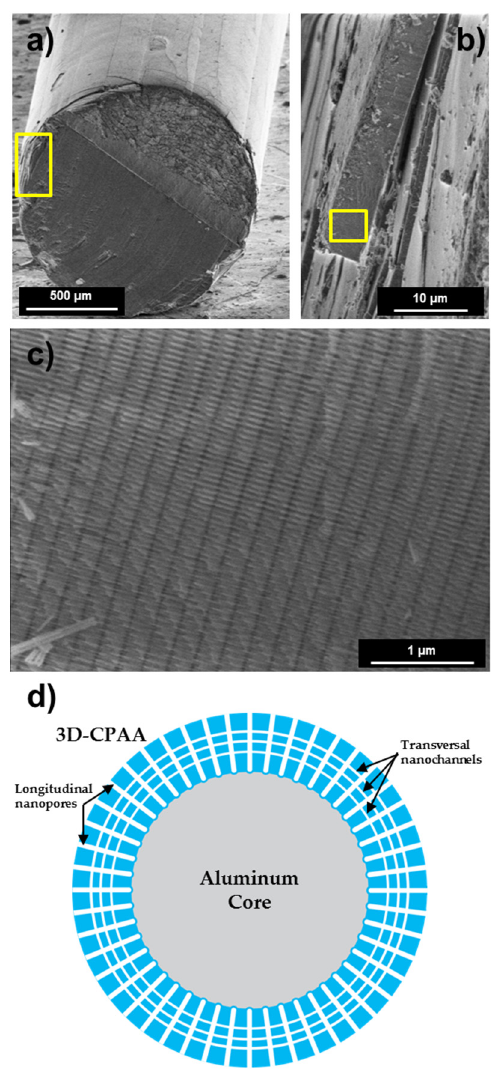
Figure 3. Cross ‐ sectional image of the S180 type sample after a mechanical cut. ( a – c ) Higher magnification images of limited areas marked by the yellow squares. ( d ) Schematic cartoon of the 3D ‐ CPAA/aluminum wire cross section.